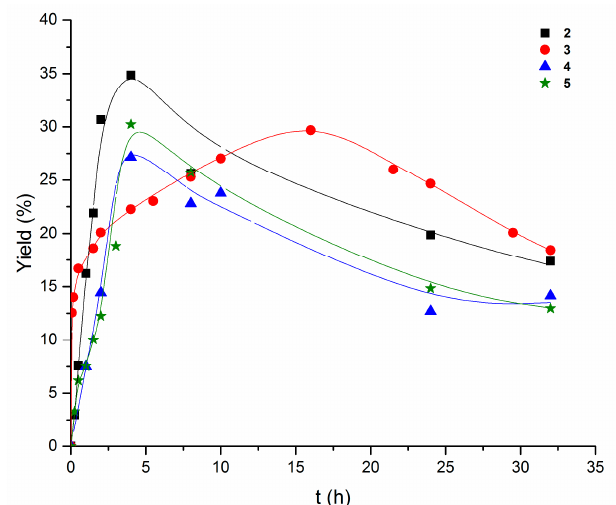
Figure 5. Comparison of the accumulation of oxygenates with time (0–32 h) in the cyclooctane (initial concentration 0.25 M) oxidation with H 2 O 2 (1.2 M) in the presence of HNO 3 (0.072 M), catalyzed by 2 – 5 (10 − 3 M) in acetonitrile at 60 °C.